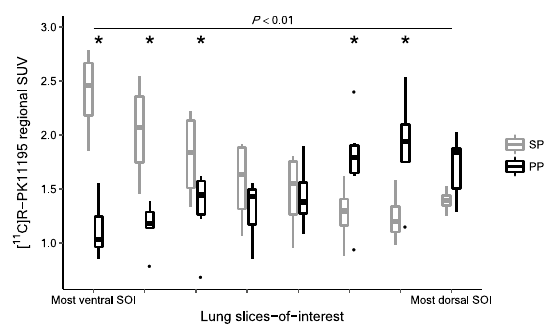
Fig. 1 Effect of PP on regional macrophage recruitment during experi‑ mental